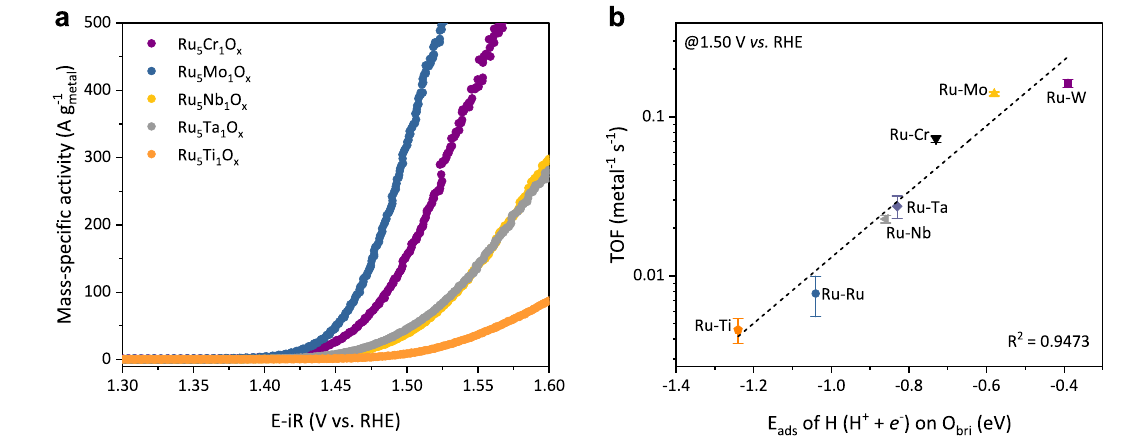
b The TOF value of different catalysts (regarding all metal atoms were active sites) as a function of H adsorption energy on O bri